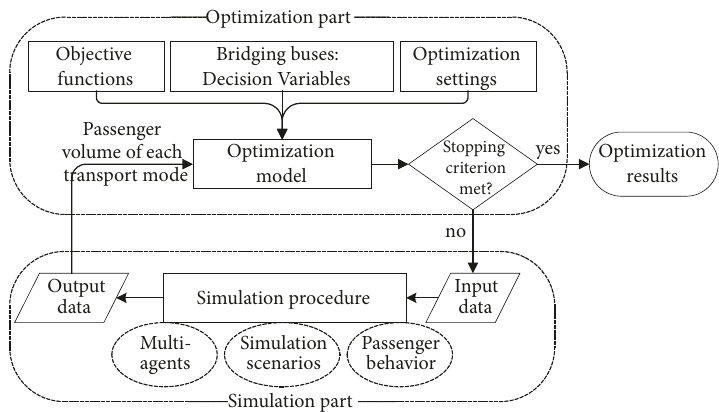
Figure 2: The basic framework of station disruption controlling